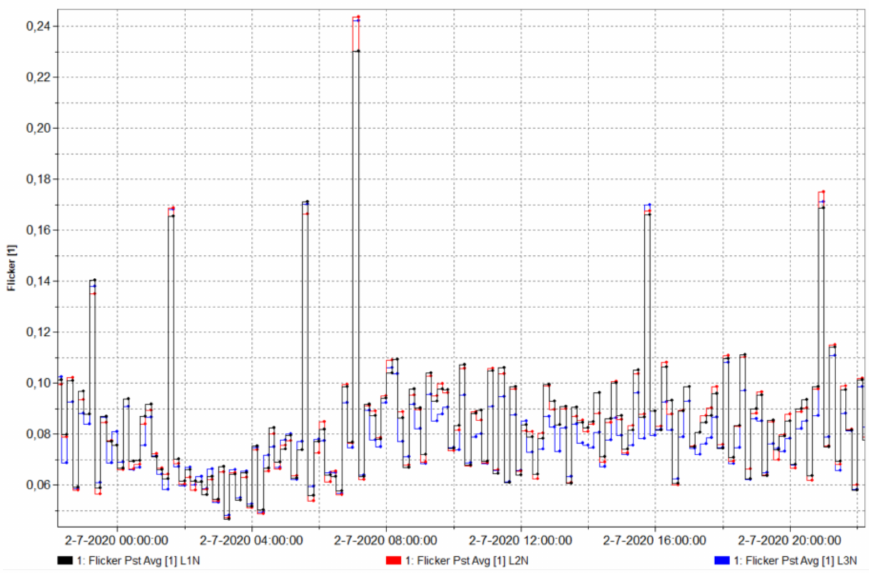
Figure 7. Pst values of a fast-charger connected at the installation. The harmonic voltage and current emissions are also measured at the fast-charger terminal. The measured values are compared with the standard limits, as shown in Table